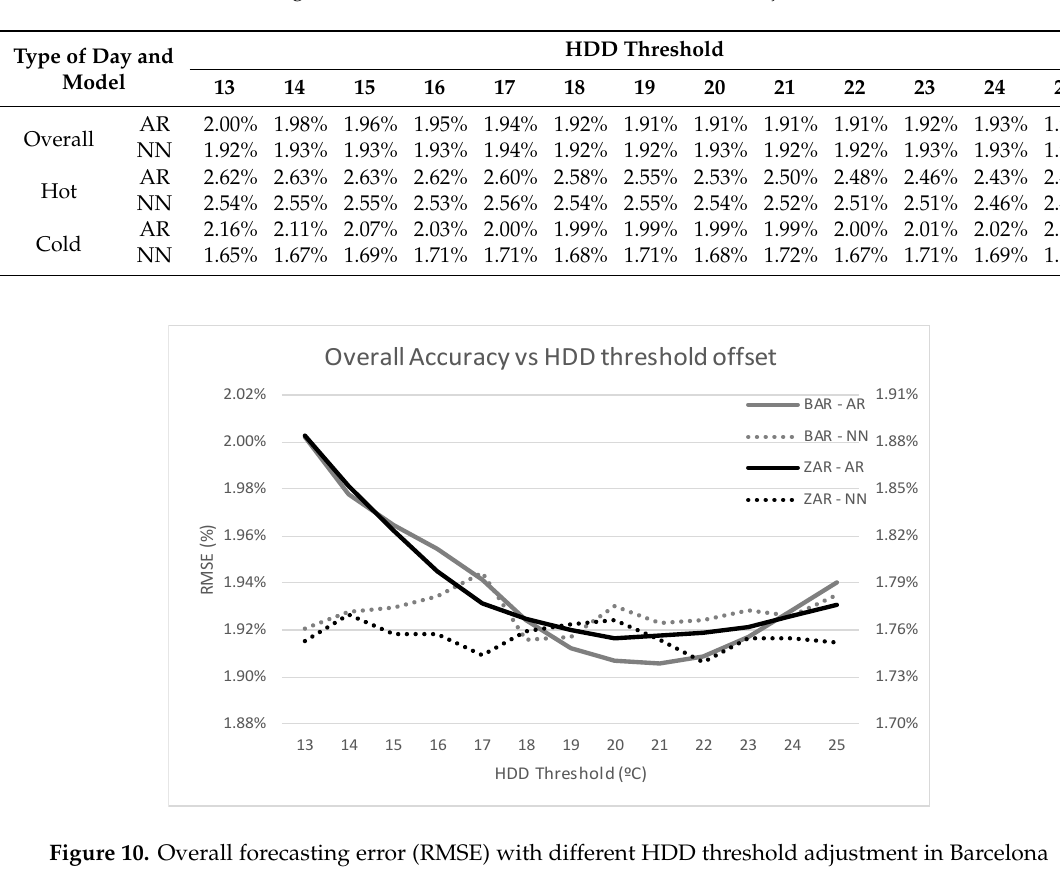
Table 4. Forecasting error (RMSE) with different HDD threshold adjustment in Barcelona.